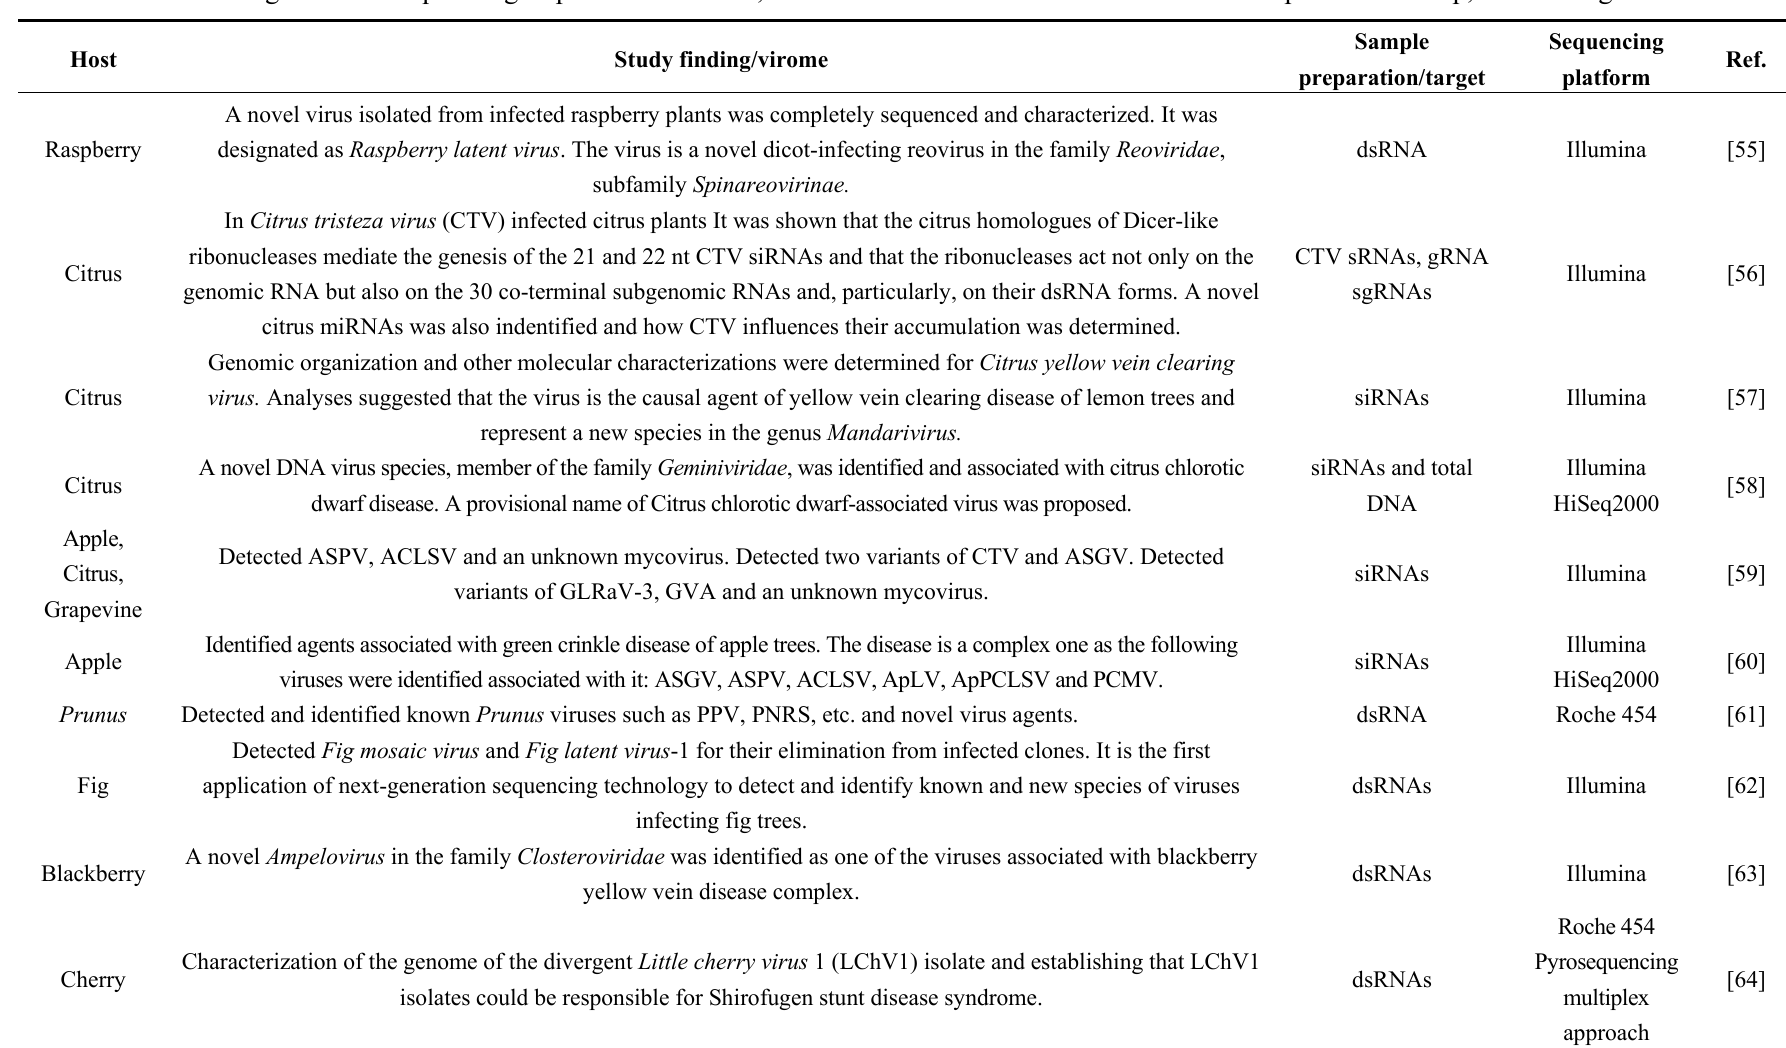
Table 4. Next-generation sequencing of plant viral siRNA, total RNA or dsRNA from virus-infected temperate fruit crop, citrus or fig hosts. Host Study finding/virome Raspberry